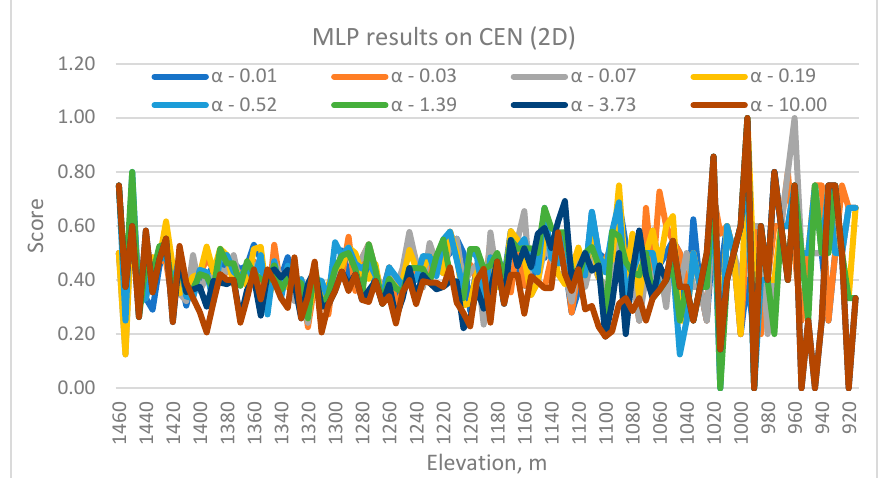
Figure 2. Box plots of results in various α on MLP performance in NW.